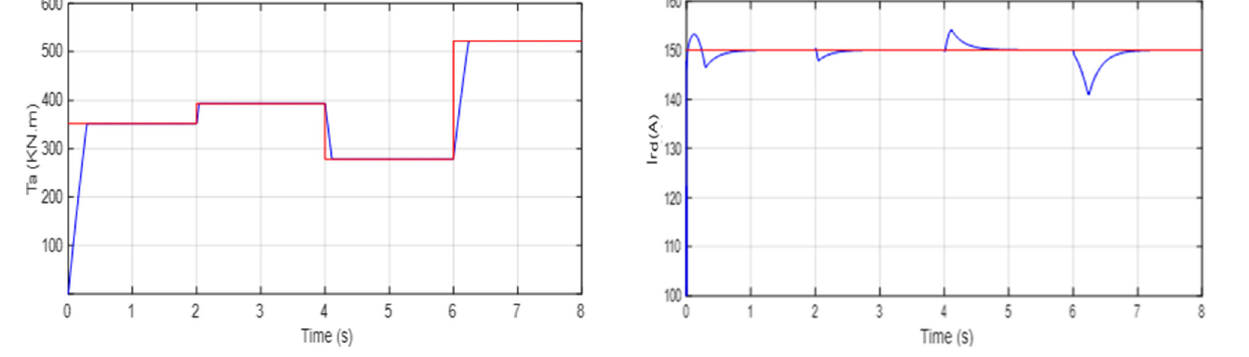
Fig. 13 Current tracking performance for PI